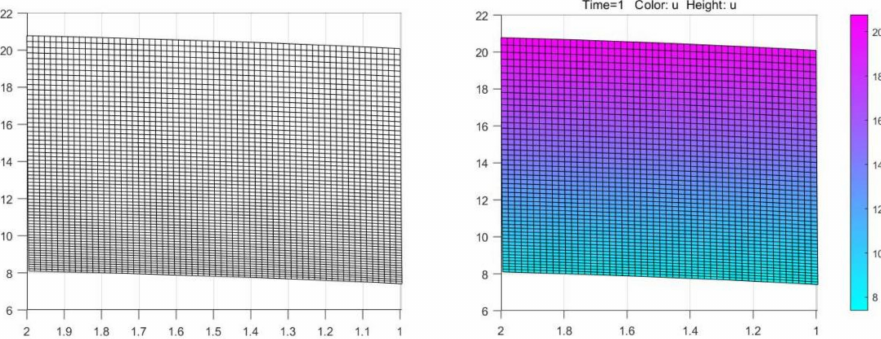
Figure 8. Longitudinal section contrast.